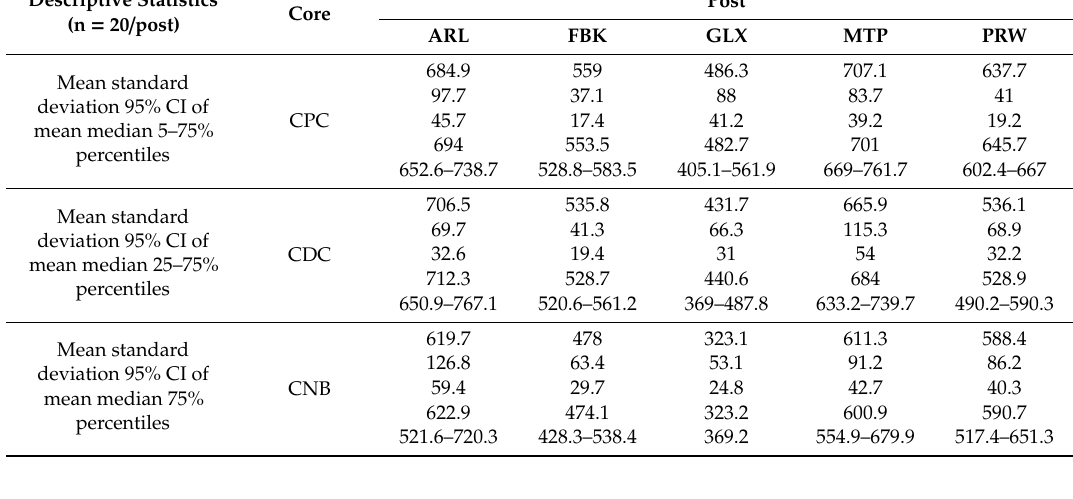
Table 2. Results of descriptive statistics for the fracture strength (in N) of the post–core pairs tested.